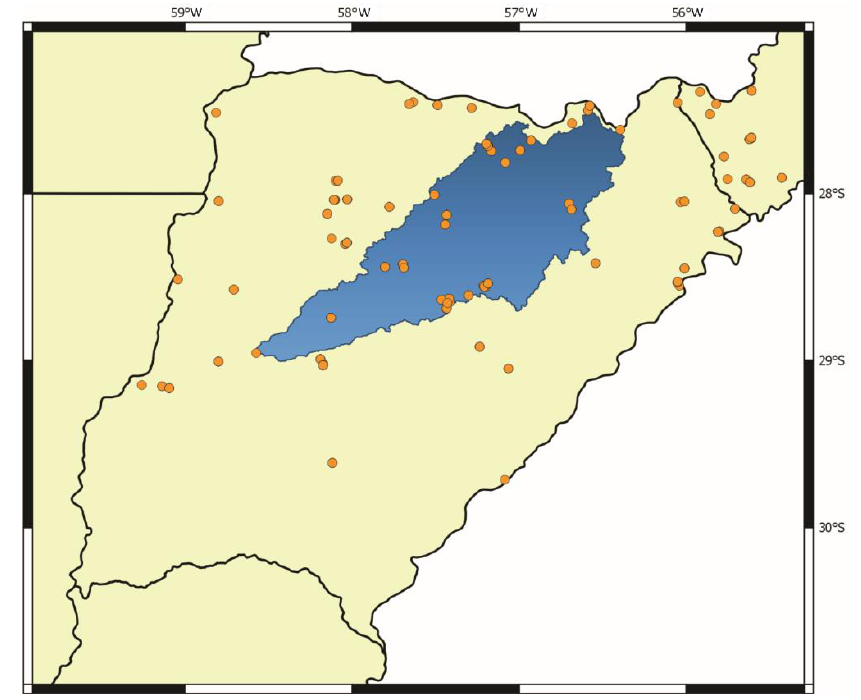
Figure 5. Localities sampled (see Supplementary Data S2 for georeferences).